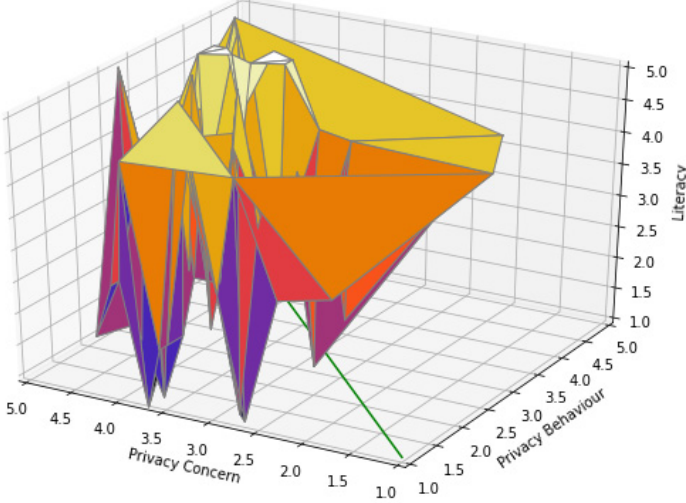
Figure 5. The spread of the results in the privacy paradox space.